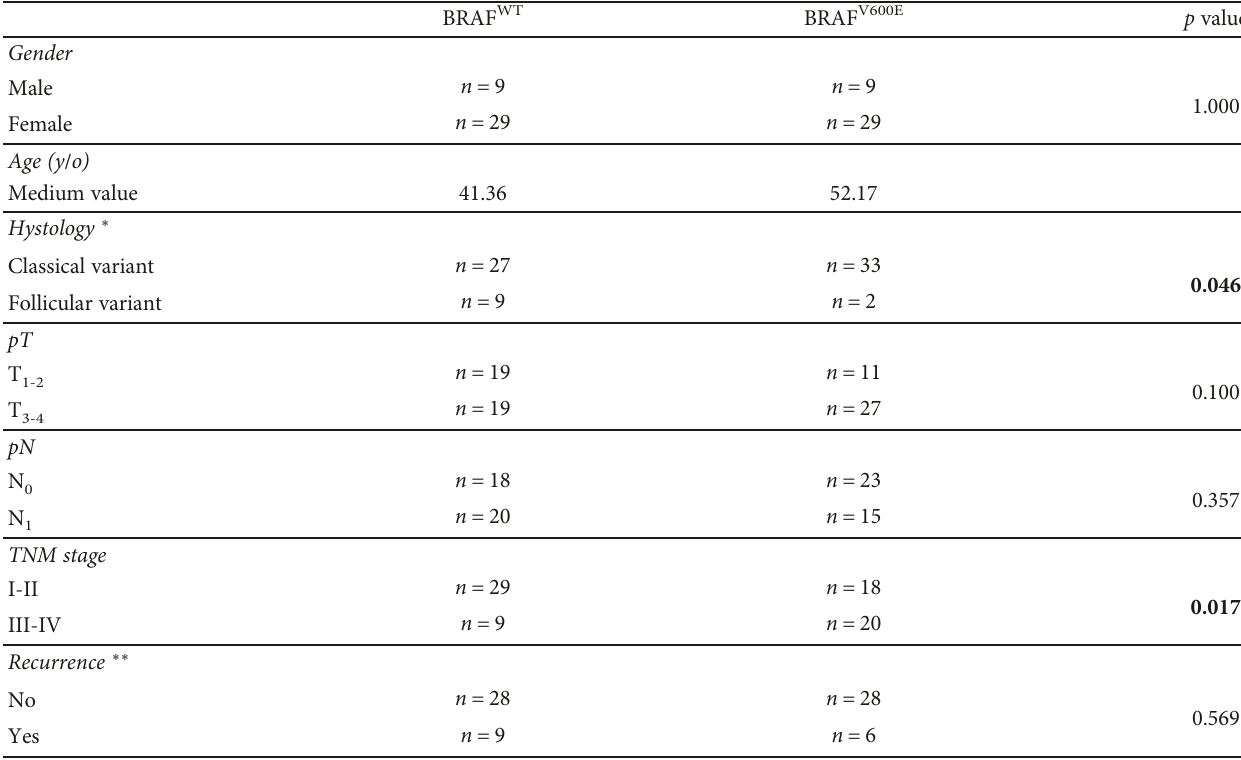
Table 4: Results from Fisher ’ s exact test to evaluate the association of clinicopathological features and the following groups: BRAF WT (38 patients) and BRAF V600E (38